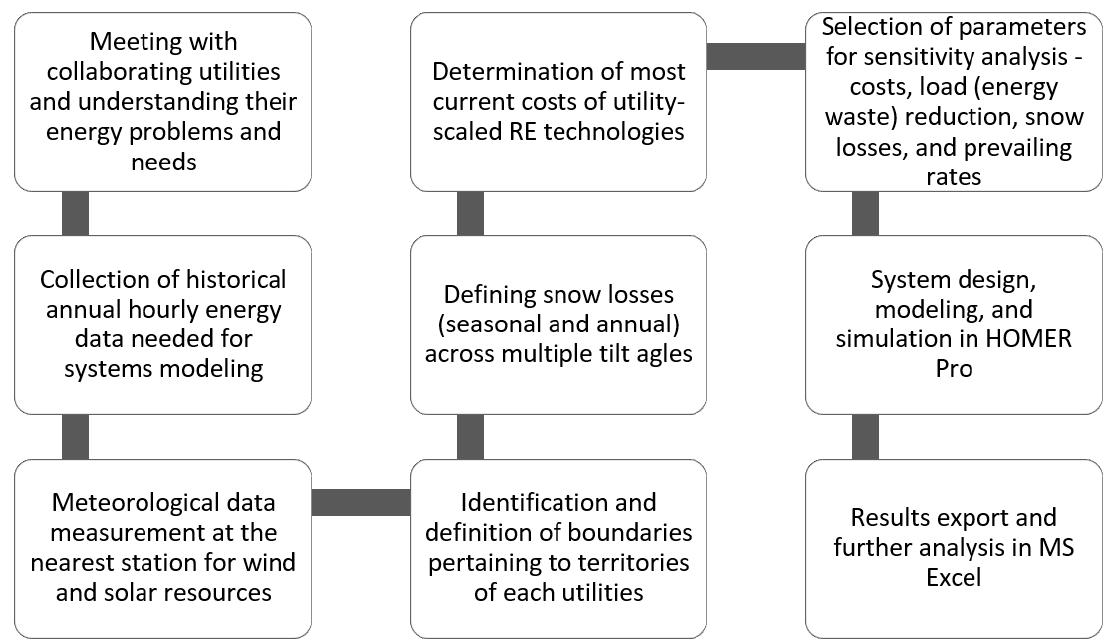
Figure 2. A schematic of phases involved in systems design and 100% RE modeling.